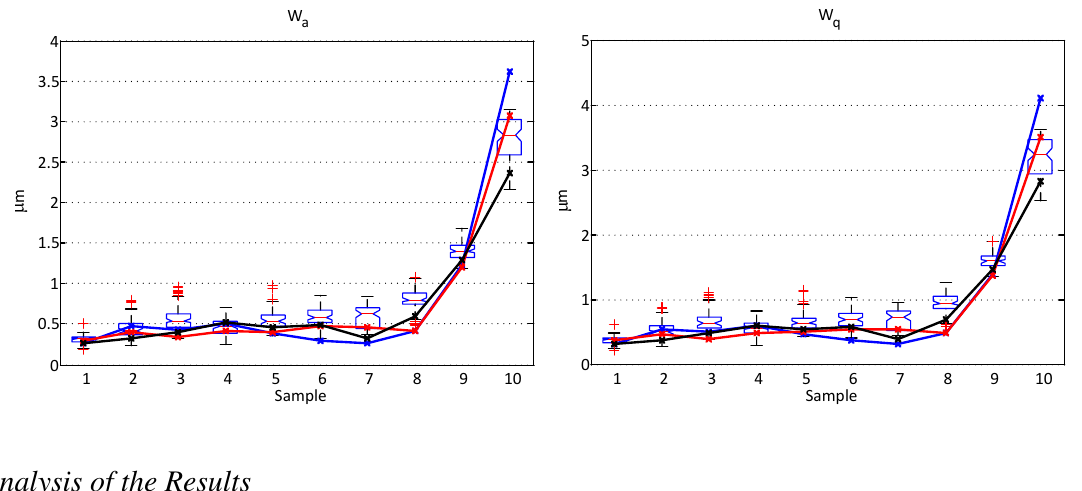
Figure 8. Comparison of results between a contact stylus profilometer and the proposed optical sensor for the waviness parameters W and W using a cutoff wavelength of a q 0.8 mm. The boxplots represent the dispersion of the parameters calculated using the optical sensor data from more than 70 profiles of each sample. The continuous lines represent the parameters calculated over three different profiles obtained from the contact stylus instrument. The rest of the parameters have been omitted in this case, as the results were similar to those in Figure